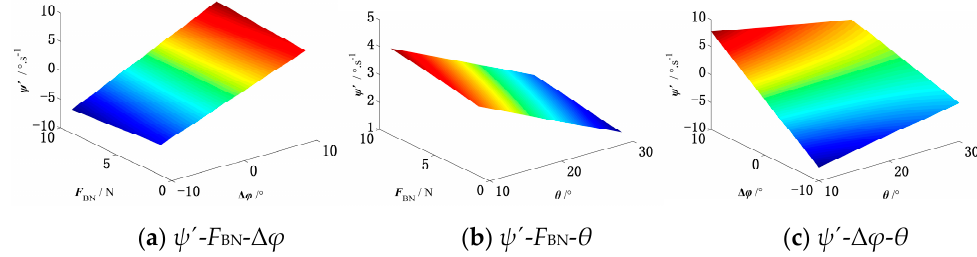
Figure 8. Approximate model of horizontal velocity.